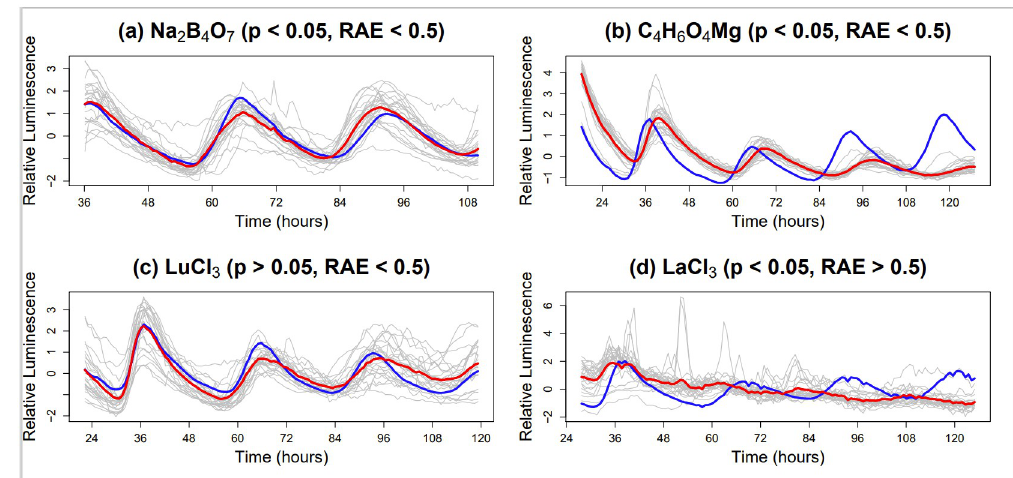
Fig 1. Excess external chemicals vary in their effects on plant circadian rhythms. Examples of statistically significant (a) period shortening and (b) period lengthening (FFT–NLLS, p < 0.05, RAE < 0.5) and examples (c, d) showing clear circadian disruption not captured by FFT–NLLS ( p > 0.05 or RAE > 0.5). Each panel: individuals in the treatment group (grey) are shown along with the treatment group average (red) and the control group average (blue). Each time series has been standardised to have mean